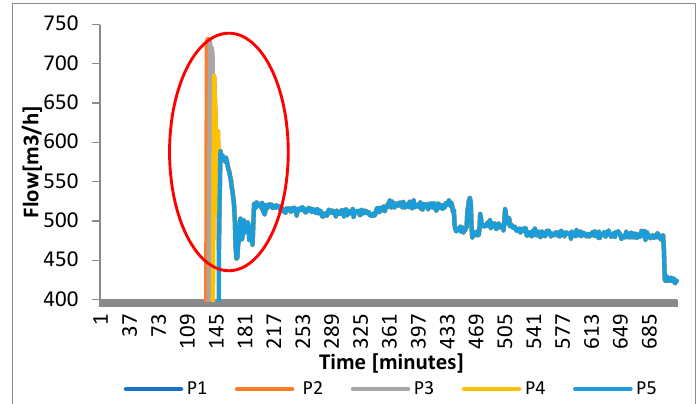
Figure 7. Flow values during one day.